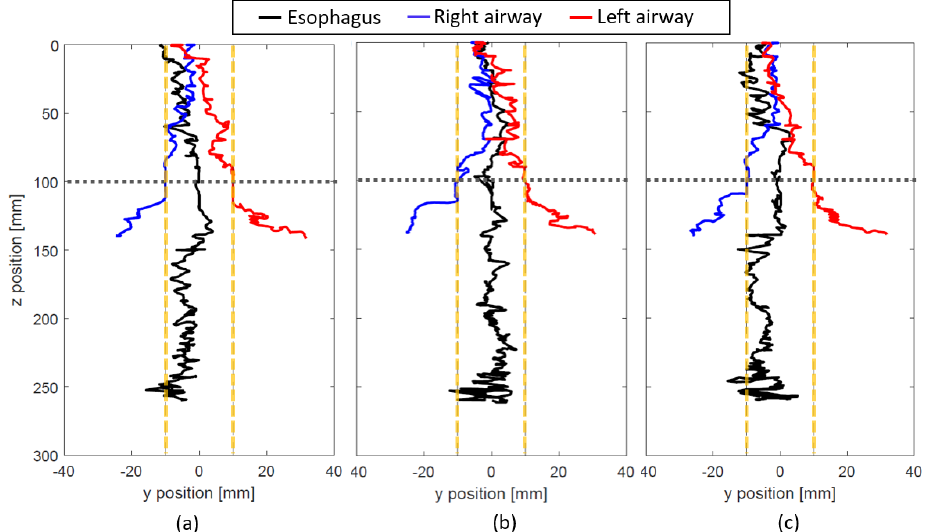
Figure 8. Tracking experiment with the dimensionally accurate mock-up esophagus and airway when L = 80 mm. Three trials of inserting the NGT into each path (the esophagus (black), right airway (blue), and left airway (red)) are shown in ( a – c ). The inner diameter of the esophagus and trachea is represented by the yellow vertical dashed lines. The horizontal dashed line indicates the vertical location of the sensors.